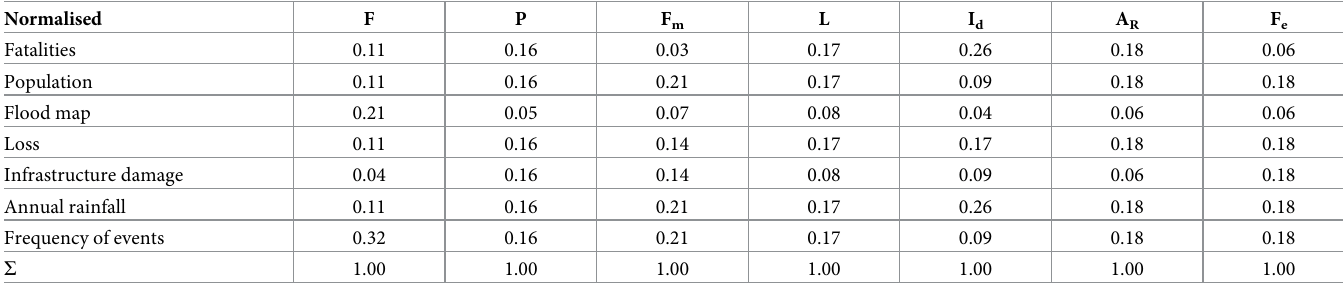
Table 8. Normalisation of vulnerability indices for Chhukha